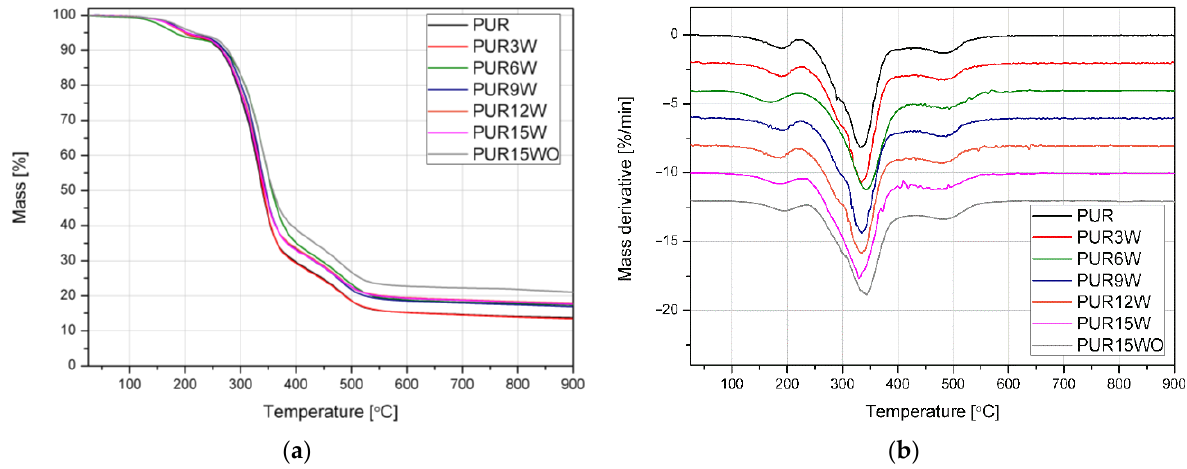
Figure 10. TG ( a ) and DTG ( b ) curves of polyurethane samples with various contents of vermiculite. Table 5. Thermal parameters obtained by TGA for PUR and PUR-based composites modified with various vermiculite